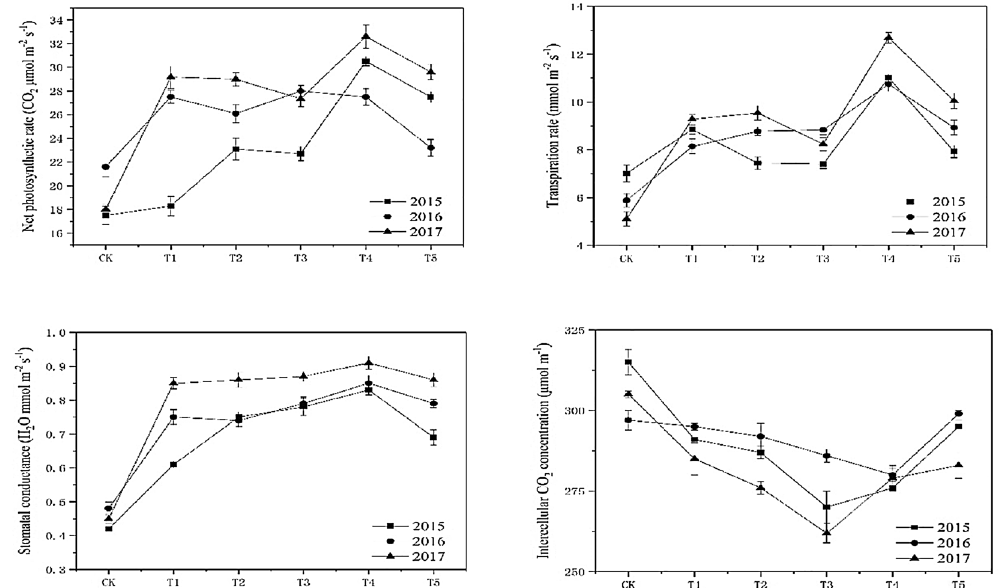
Figure 4. Effect of biochar treatment on the photosynthetic characteristics of tobacco. Note: Six biochar application levels: CK = 0 kg/ha, T1 = 600 kg/ha, T2 = 1200 kg/ha, T3 = 1800 kg/ha, T4 = 2400 kg/ha, T5 = 3000 kg/ha; The error bars are standard